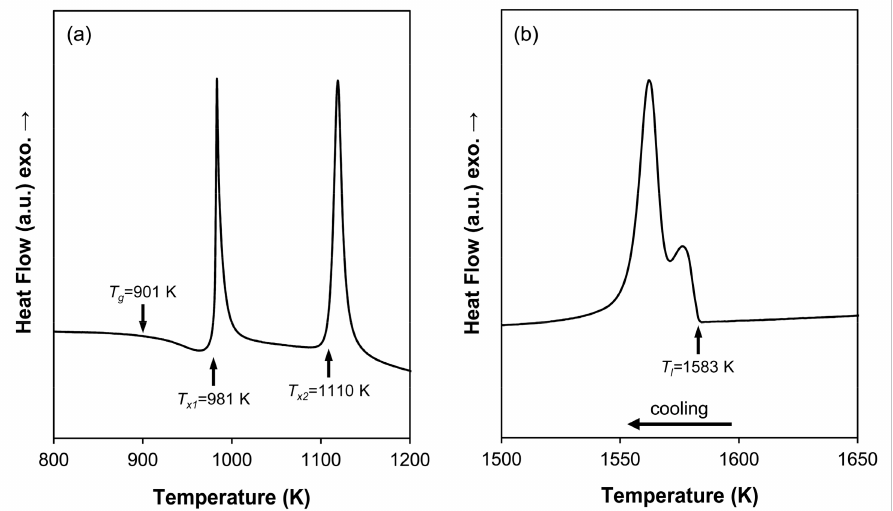
Figure 1. DSC scan of Ni 33.6 Co 23.2 Zr 0.5 Ta 4 W 23.7 B 15 alloy. ( a ) Glass transition and crystallization behavior, ( b ) Melting behavior.